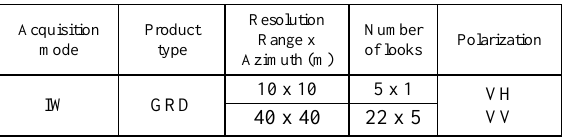
Table 1. The characteristics of the Sentinel 1 data used (ESA-Sentinel